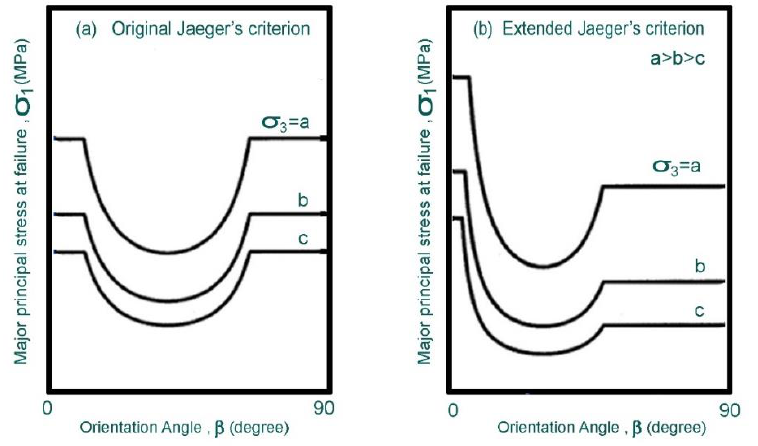
Figure 7. Diagram of strength variation versus β : ( a ) original Jaeger’s criterion ; ( b ) extended Jaeger’s criterion (Adapted from Tien and Kuo [181]). Table 21. Material constants included in the initial and modified criteria.